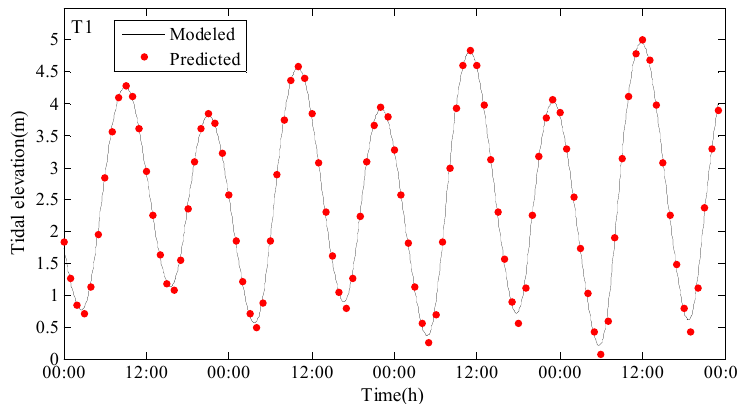
Figure 8. Comparison of modeled and predicted tidal elevation at Tanhu gauge station (30°37 ′ N, 121°37 ′ E) from 29 December 2013 through 1 January 2014.